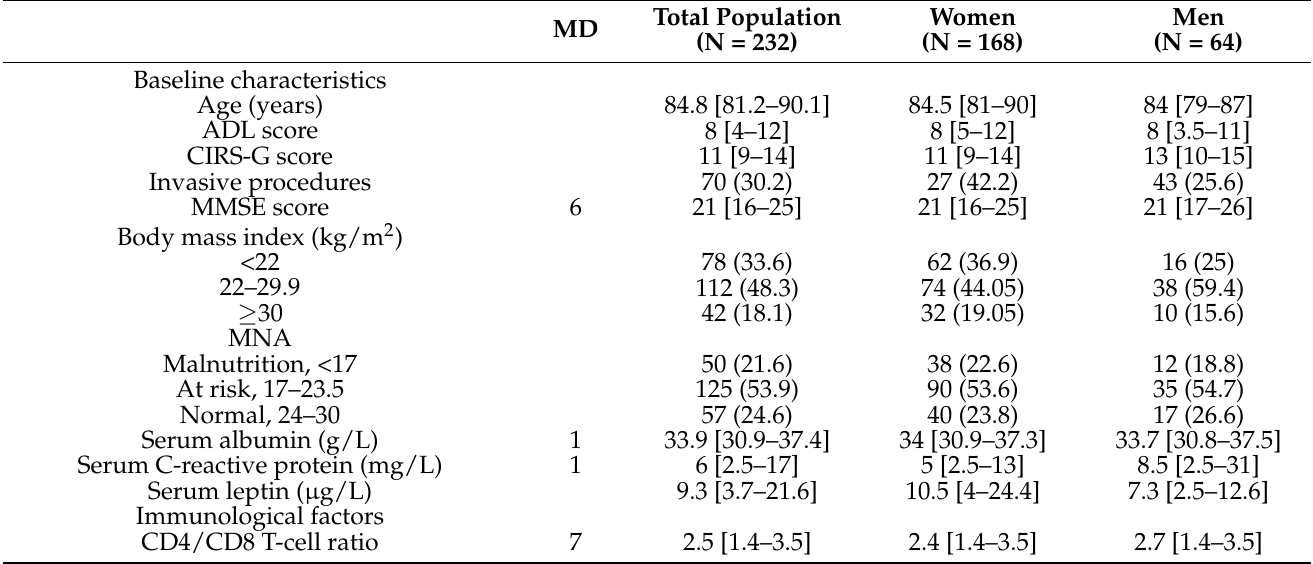
Table 1. Sociodemographic, nutritional, and laboratory characteristics of 232 patients hospitalized in a geriatric rehabilitation